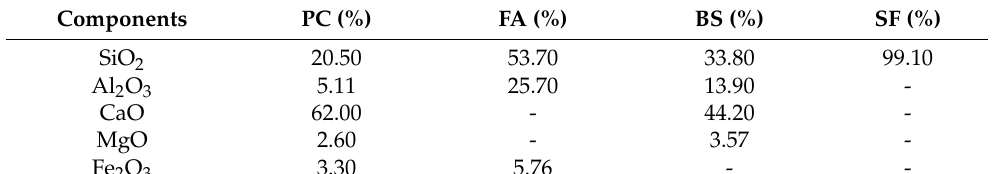
Figure 1. SEM micrographs of cementitious materials: ( a ) PC; ( b ) FA; ( c ) BS; ( d ) SF.